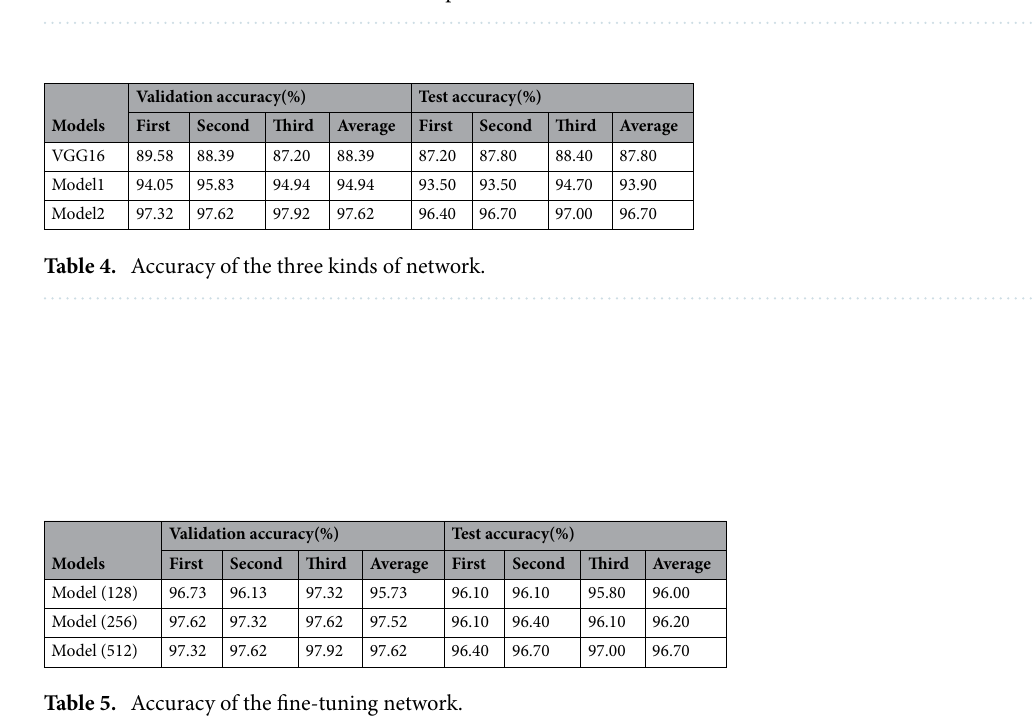
Table 3. Three kinds of network model comparison.